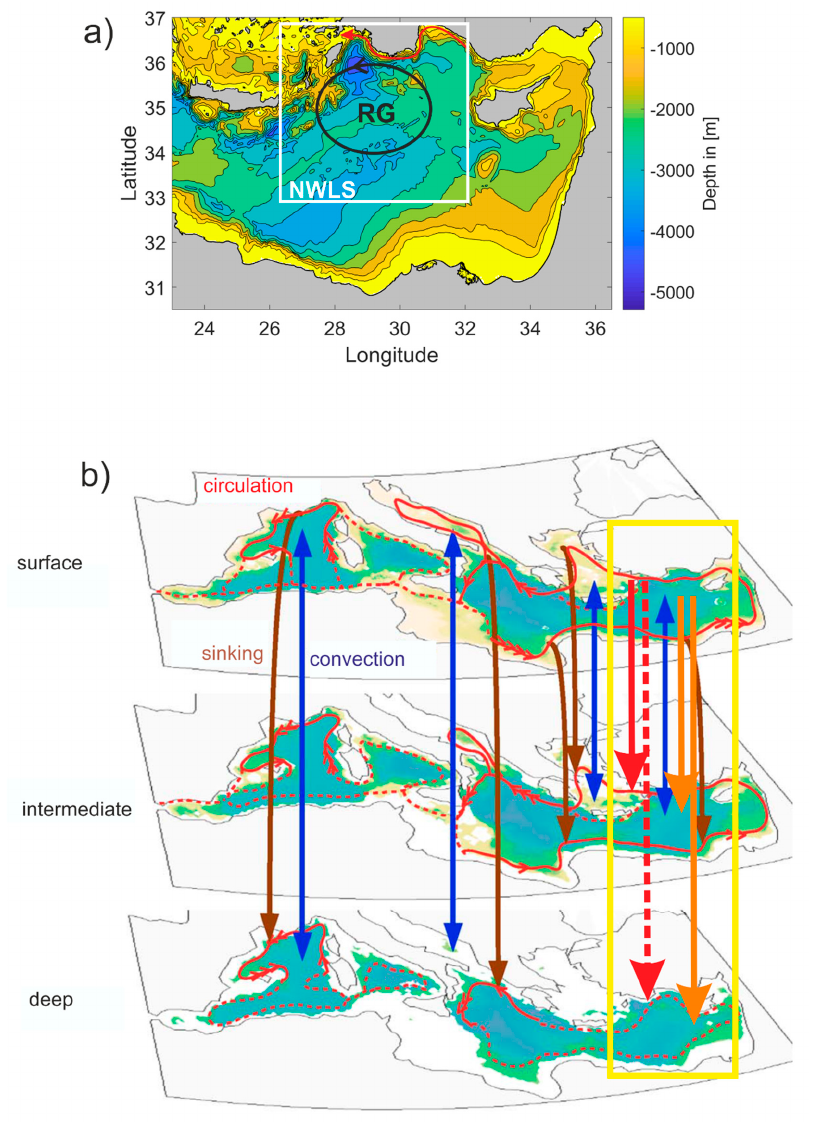
Figure 22. ( a ) The white rectangle confines the area of study, the NWLS. Typical LIW formation was found along the Northern coastline (red arrow), while ‘lower range’ LIW and LDW formation was found within submesoscale eddies within the center of RG (black ellipse). ( b ) This figure, adapted from [15], summarizes the obtained results for winter seasons in the NWLS (yellow rectangle): Dense water formation along the Northern coastline reached intermediate (200–500 m; red line) and deeper layers (500–600 m; dashed red line), while LDW formation within the center of RG reached intermediate and deep layers (at least 1000 m; orange